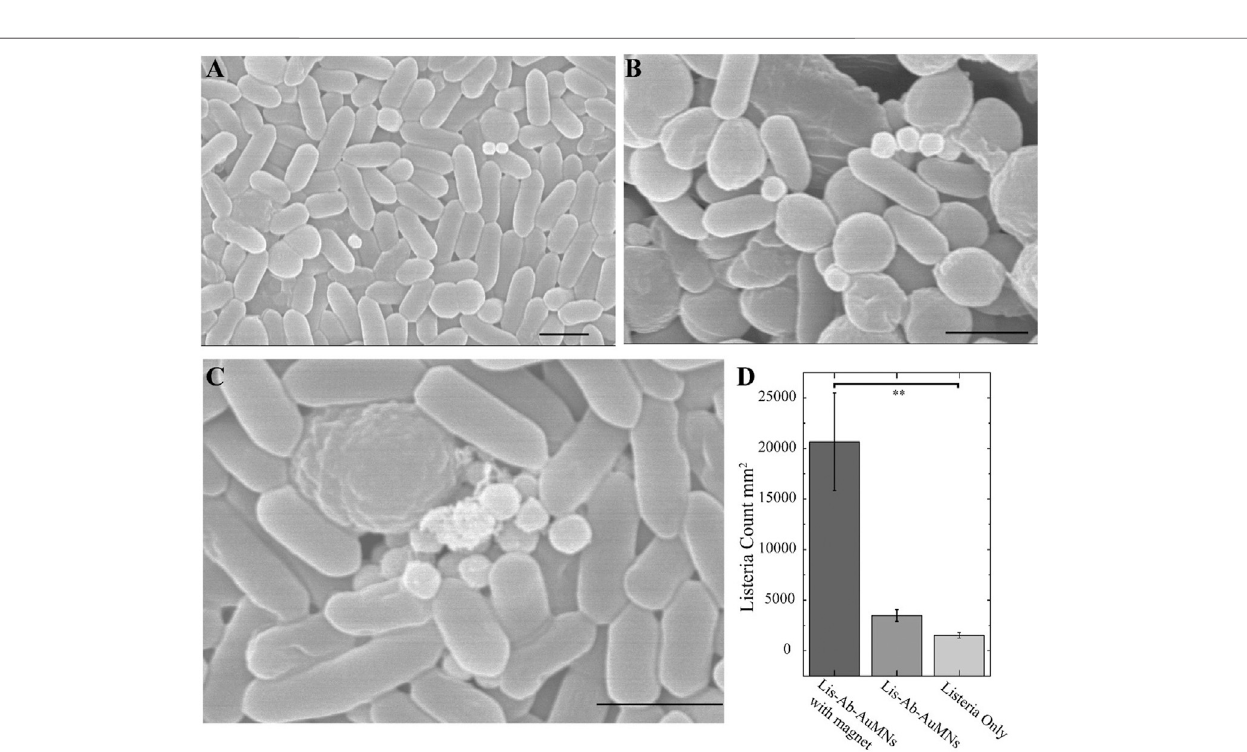
FIGURE 7 | (A) HR-SEM of a general region ofthe aggregated L. monocytogenes displaying afew pAb-Lis-AuMNs on top of the bacteria. (B, C) HR-SEM images showing pAb-Lis-AuMNs bound L. monocytogenes aggregates while under the presence of a magnet; (C) shows multiple pAb-Lis-AuMNs aggregating bacteria in a multilayer structure as depicted in Figure 1 . (D) L. monocytogenes counts as determined under optical microscopy utilizing Gram staining exhibits a 99% con fi dence one-way ANOVA suggesting statistically signi fi cant differences in the mean L. monocytogenes counts between the three tested conditions. (The scale bar for all images is 1